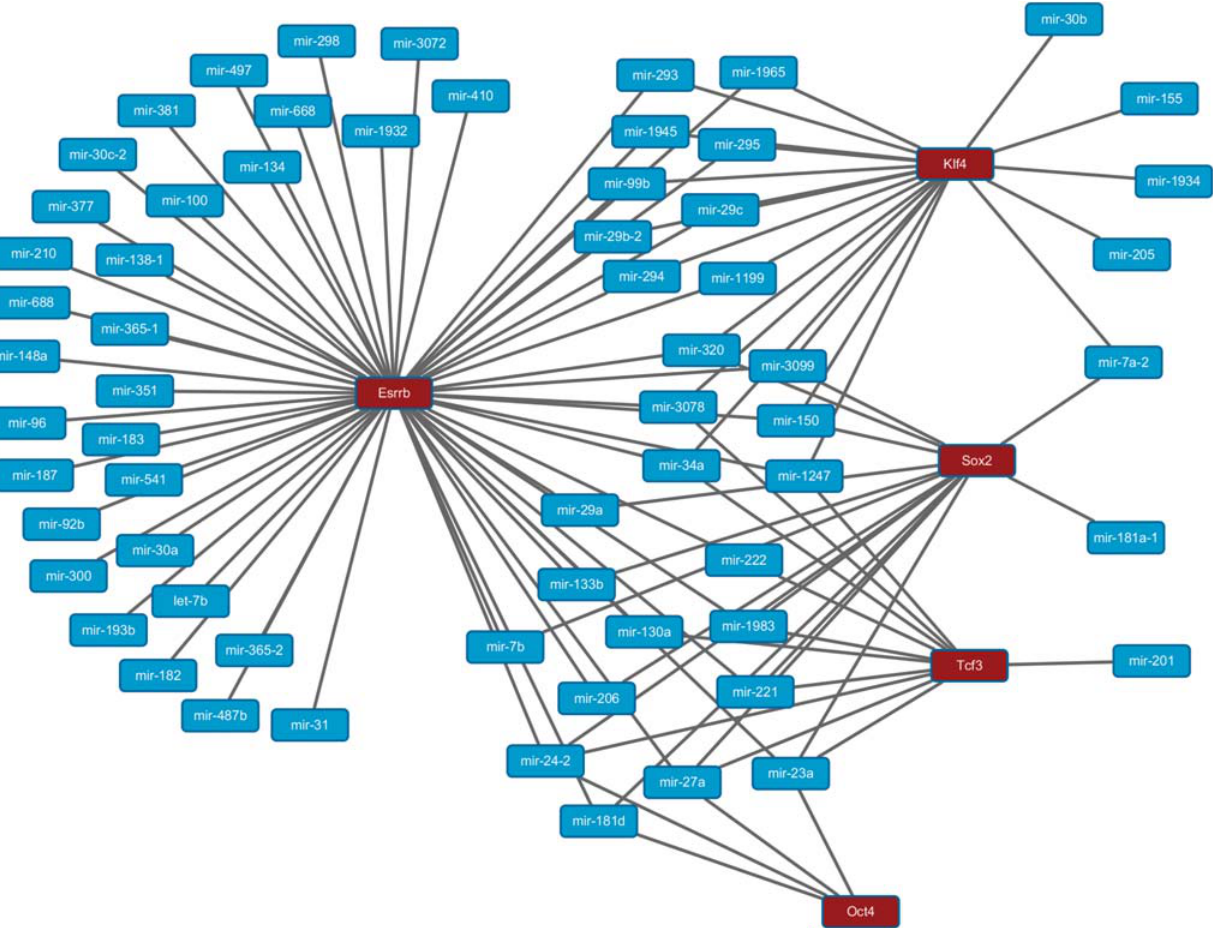
Fig 7. The inferred regulatory relationships for the five TFs studied in our work. The red boxes indicate the five TFs and the blue boxes indicate the miRNAs. The lines between the red and blue boxes indicate the regulatory relationships between the two